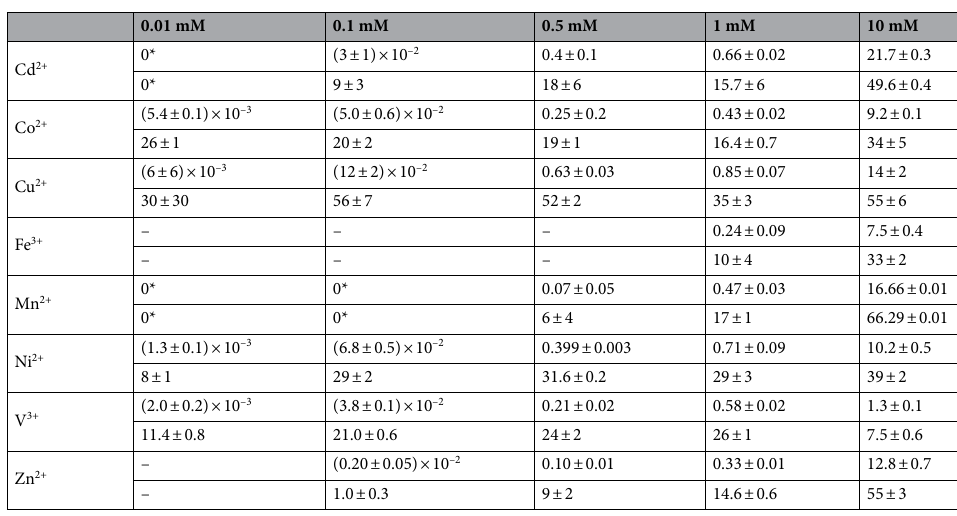
Table 1. Metal ion adsorption at pH 7 calculated as the difference between the initial and final concentration of the loading solution. For each condition, the results are reported in mg·g −1 of the byssus matrix above and the percentage of metal adsorbed from the solution below. The results not reported gave problems due to ion desorption from the matrix. ( *, # ) No difference was observed with the loading solution. The standard deviation is reported. # The desorption concentration of metal ions from the byssus matrix in 2 ml of the buffer-only solutions are reported in table